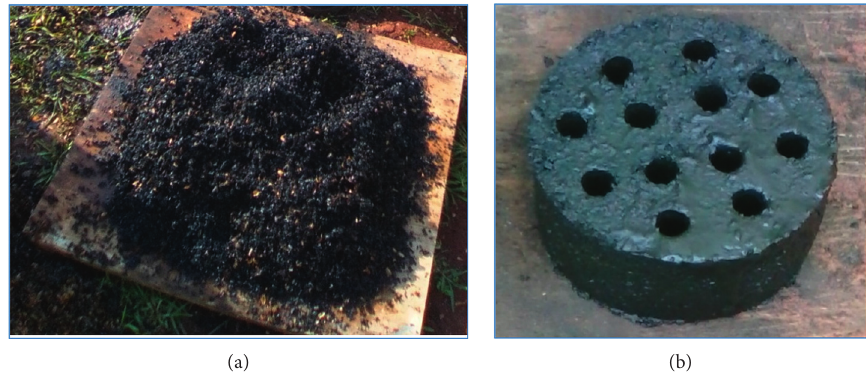
Figure 8: Preparation of fuel briquette using coffee husk char. (a) Fuel briquette. (b) Carbonised